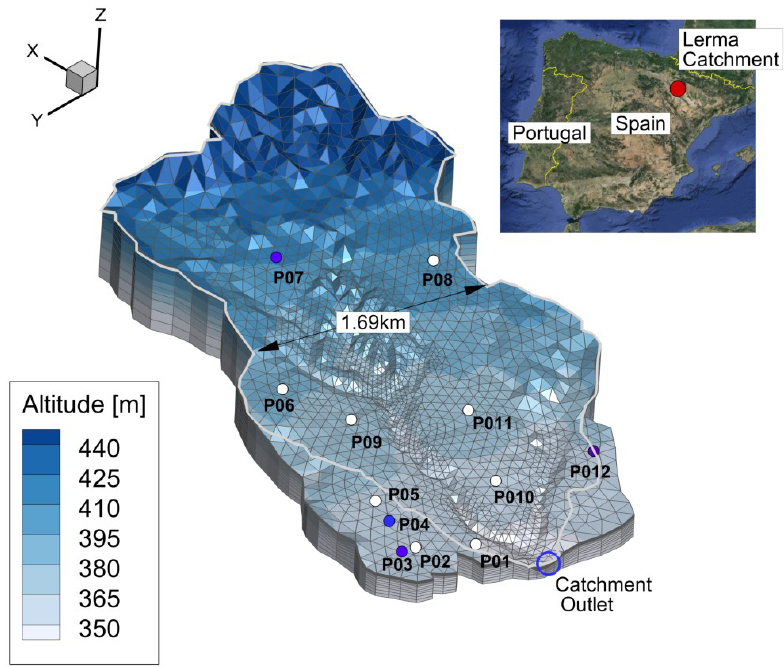
Figure 1. Surface elevation of the Lerma catchment (ma.s.l.). The observation wells drilled in 2010 are indicated by blue circles and the ones drilled in 2008 are indicated by white circles. The gray line represents the limits of the surface flow domain. Vertical exaggeration: 5 : 1. Modified from von Gunten et al. (2014,